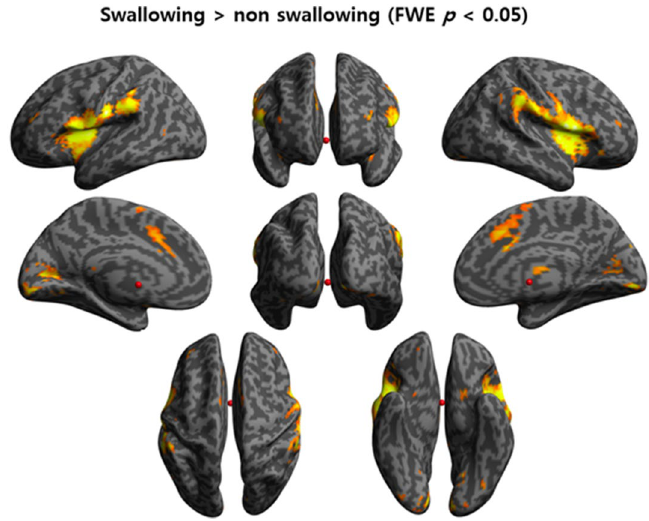
Figure 2. BOLD signal in swallowing task contrasted with that in non-swallowing task. In the cognition- subtracted activation of swallowing versus non-swallowing tasks, the BOLD signal is predominantly seen in both the lateral precentral gyri, postcentral gyri, anterior insular cortices, supramarginal gyri, pre-SMA, and right thalamus. BOLD, blood oxygen level-dependent; SMA, supplementary motor area; FWE, family-wise error.